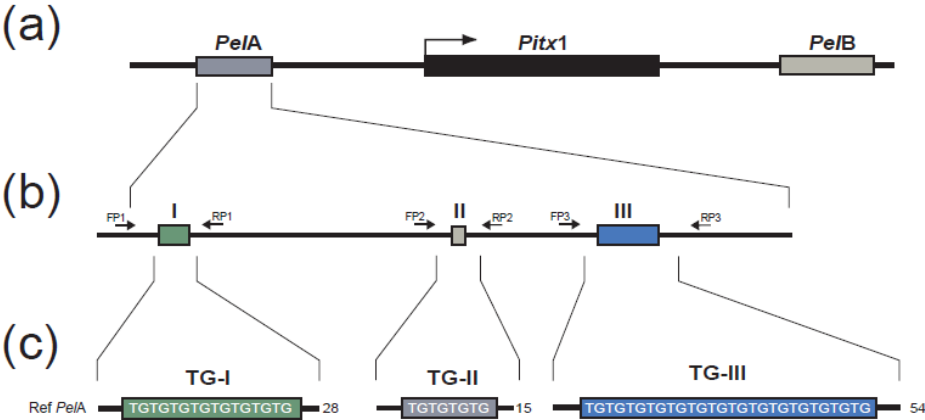
Figure 1. ( a ) Pitx 1 with the upstream and downstream enhancers Pel A and Pel B, respectively. ( b ) Pel A with TG-repeats I, II, and III, and their relative location. FP1-3 and RP1-3 show the location of the forward and reverse primers used to sequence TG-repeat I, II, and III, respectively. ( c ) The reference sequence (SALR GU130435; 377,852 nt) is from a stickleback collected in Salmon River, British Columbia, and harbours 28, 15, and 54 TG-repeats at TG-repeat I, II, and III, respectively.